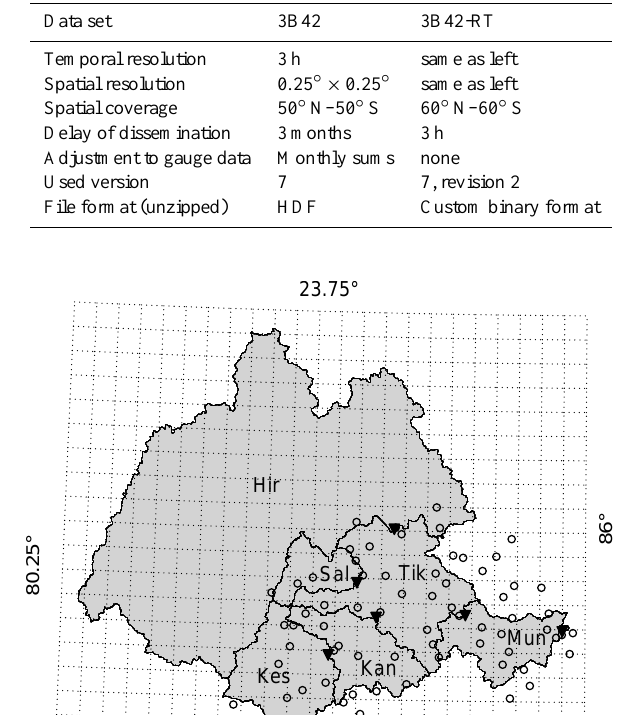
Table 1. Basic specifications of the evaluated TRMM data sets.